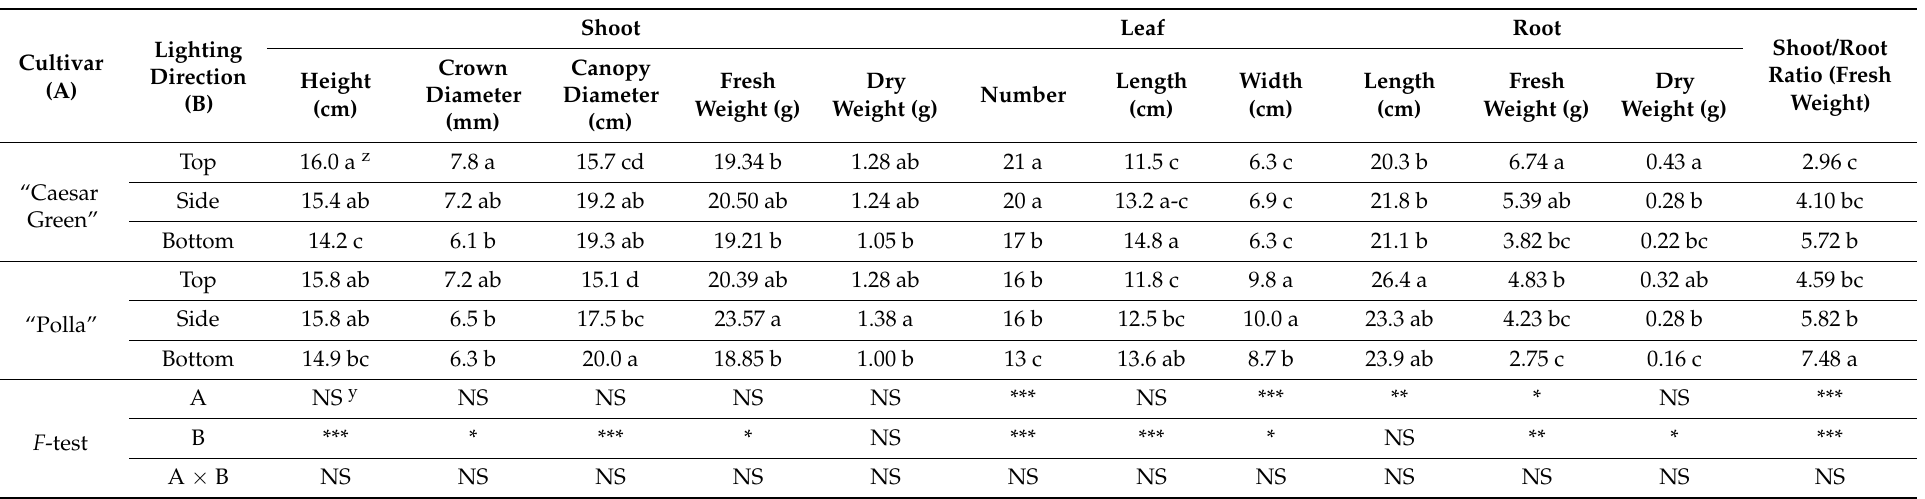
Table 1. Influence of the lighting direction on the growth and development of lettuce grown for 30